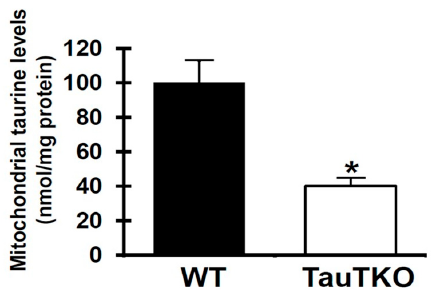
Figure 1. Reduced mitochondrial taurine content of taurine transporter (TauTKO) hearts. Following isolation of the mitochondrial fraction from homogenized hearts, extracts were prepared by precipitating protein. Mitochondrial taurine content was then measured. Values shown represent means ± SEM of 5–7 different hearts. * p < 0.05. WT, the wild-type.